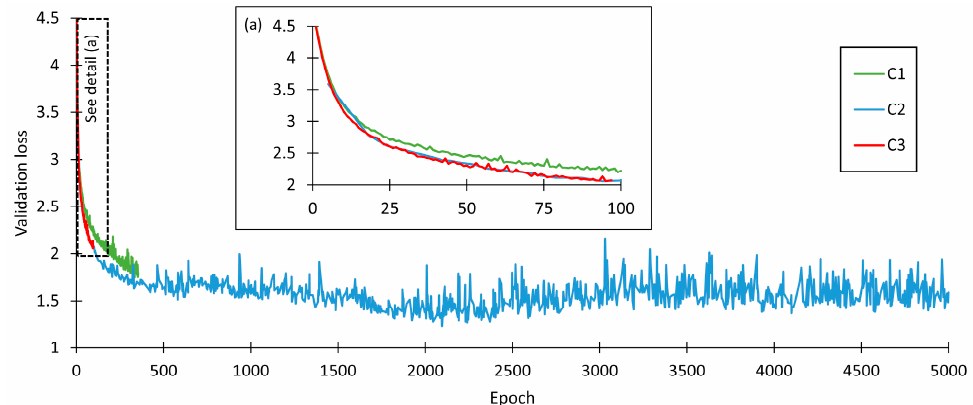
Figure 7. Effect of termination criteria. ( a ) Zoomed detail for the dash-delimited area, highlighting the early stopping of C2 parameter